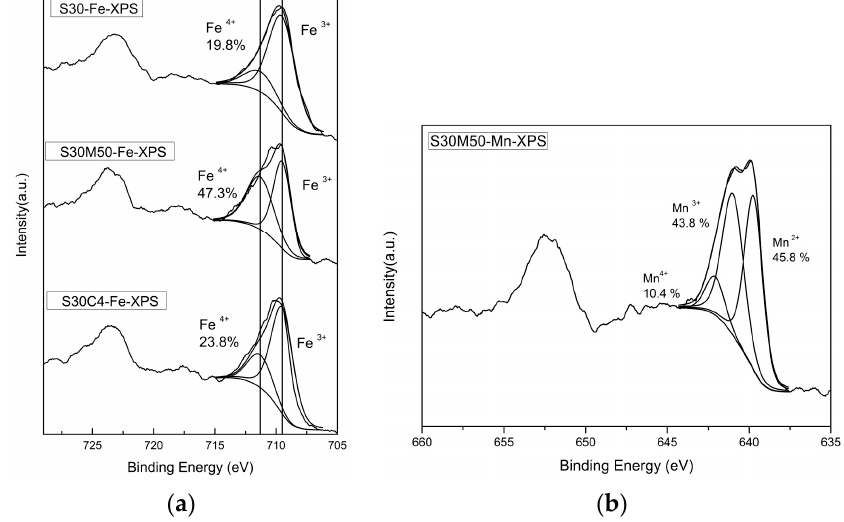
Figure 6. XPS spectra of: ( a ) Fe 2p 3/2 of the polished surfaces of three S30, S30M50 and S30C4 samples; and ( b ) Mn 2p of the polished surface of the S30Mn50 after Ar + etching for 5 s.